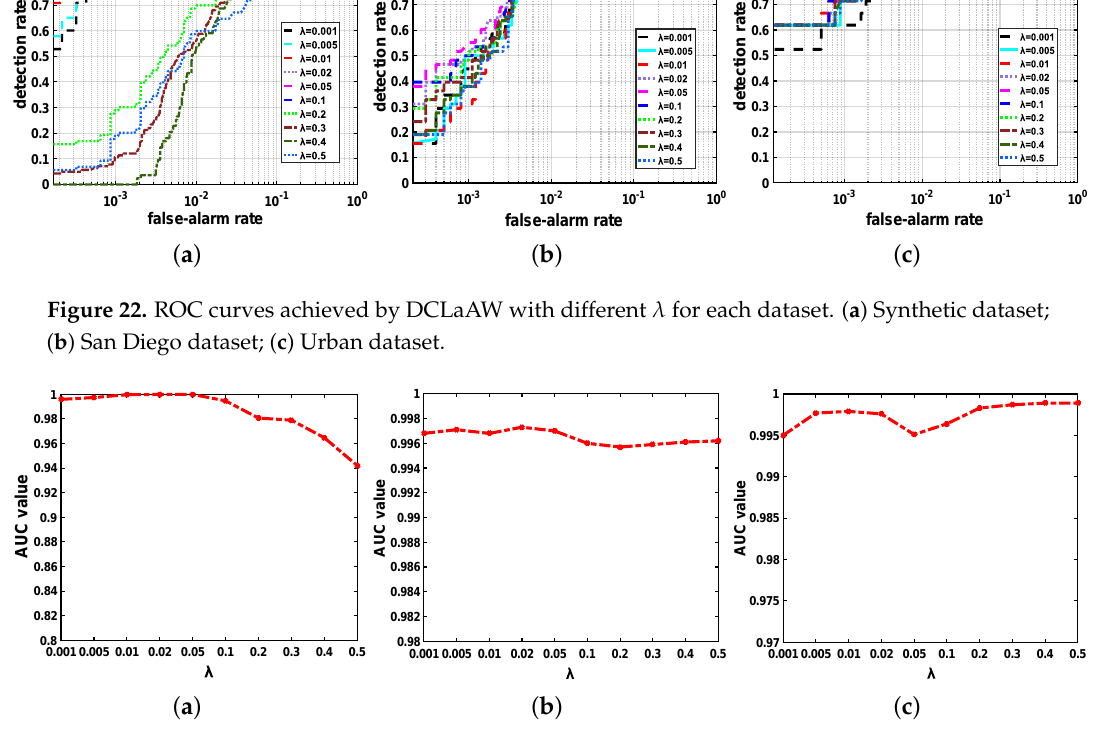
Figure 23. AUC values achieved by DCLaAW with different λ for each dataset. ( a ) Synthetic dataset; ( b ) San Diego dataset; ( c ) Urban